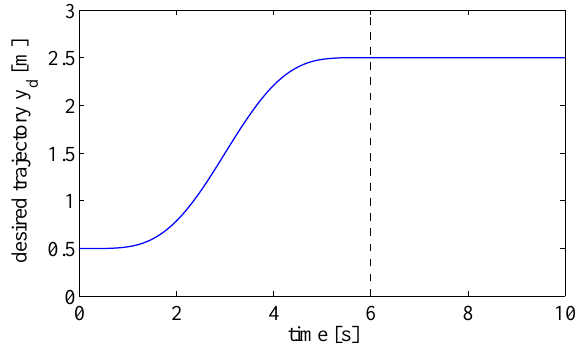
Figure 9. Desired output trajectory y d for mass m 2